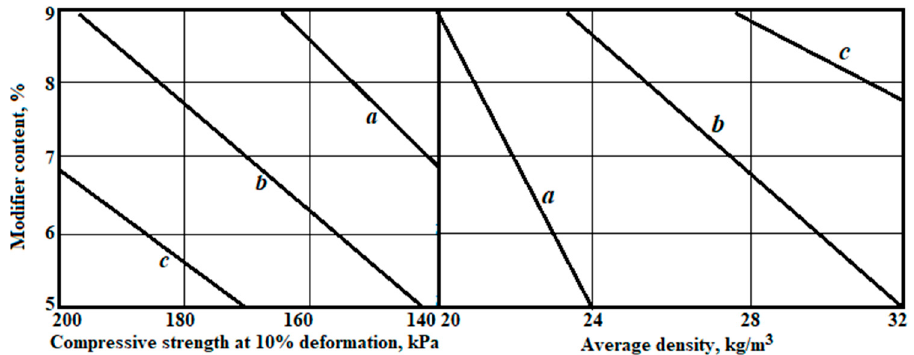
Figure 8. Nomogram for determining the consumption of recycled polyethylene and modifier, with the content of recycled polyethylene: a—10 kg/m 3 ; b—20 kg/m 3 ; c—30 kg/m 3 .